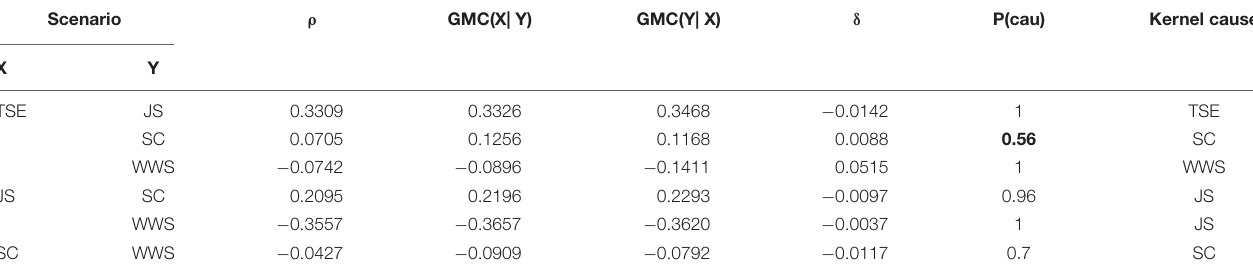
TABLE 12 | Summary of GMC for total